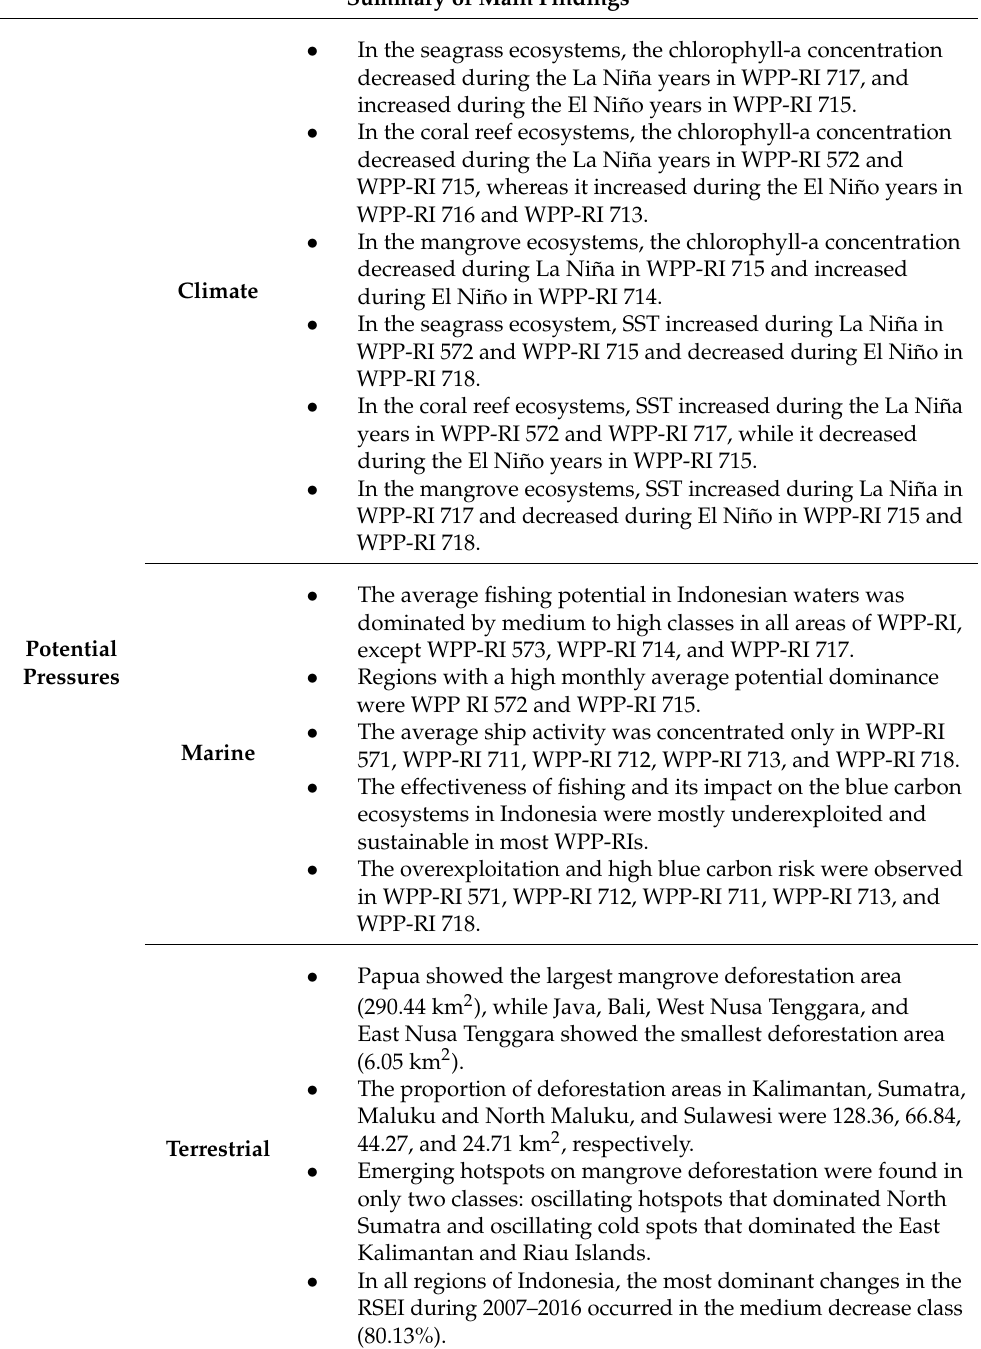
Table 3. Brief description of primary findings was discovered in this study. Summary of Main